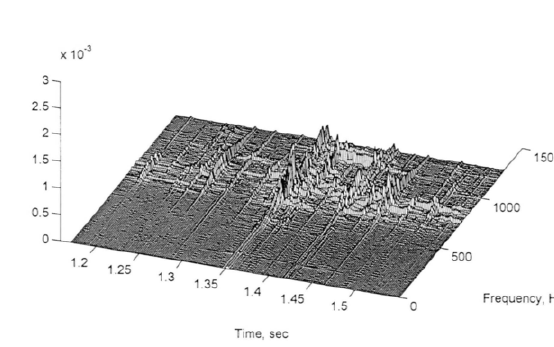
FIGURE 8 3-D meshplot of Choi- Williams distribu tion shown in Fig. 7.